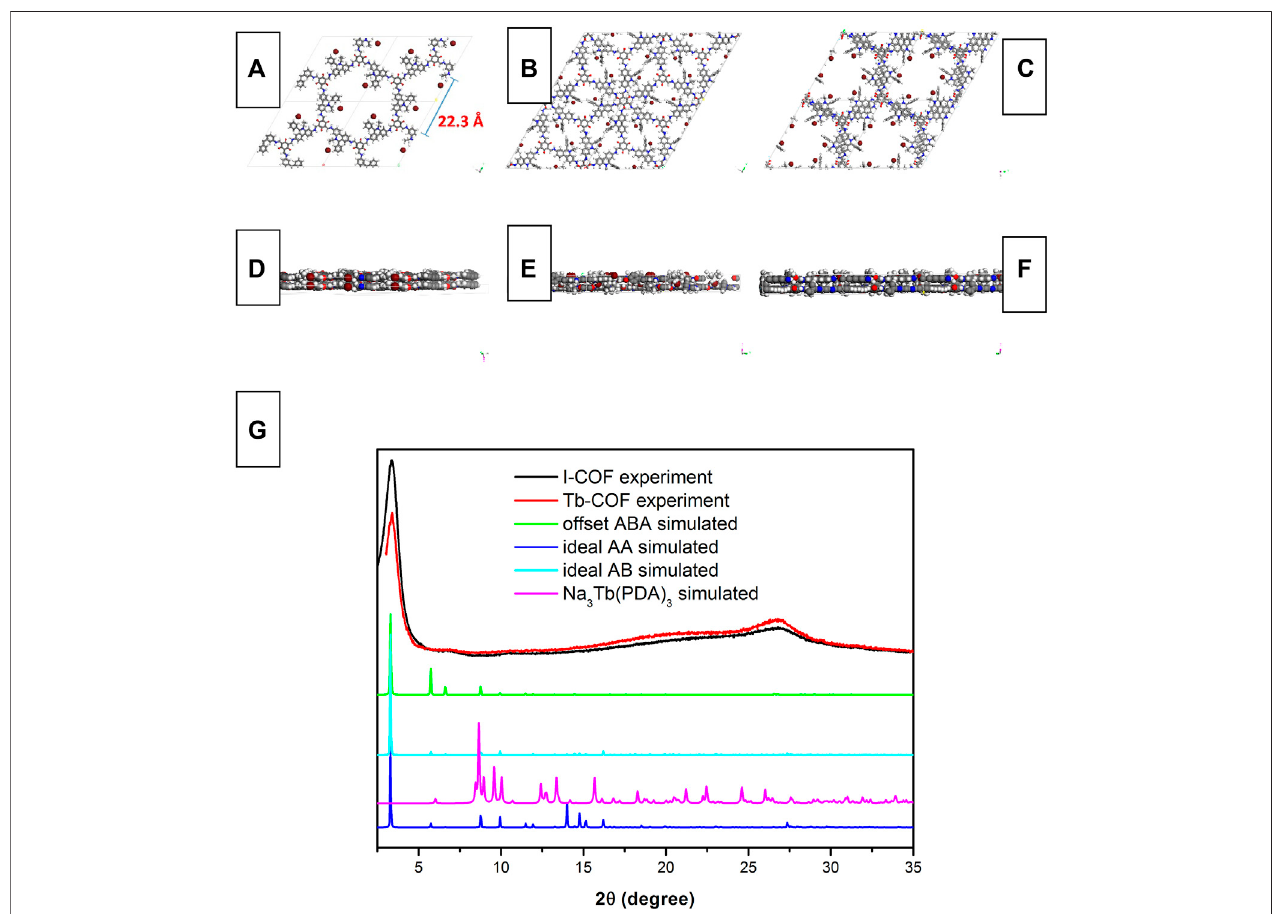
FIGURE2| SimulatedmonolayerstructureofI-COFoptimizedbytheuniversalforce fi eldmodelanditscorrespondingalignment, (A) topviewofidealAAstacking, (B) top view of ideal AB stacking, (C) top view of offset ABA stacking, (D) side view of ideal AA stacking, (E) side view of ideal AB stacking, (F) side view of offset ABA stacking, (G) XRD patterns of I-COF, Tb-COF, ideal AA stacking, ideal AB stacking, offset ABA stacking, and Na 3 Tb(PDA) 3 .